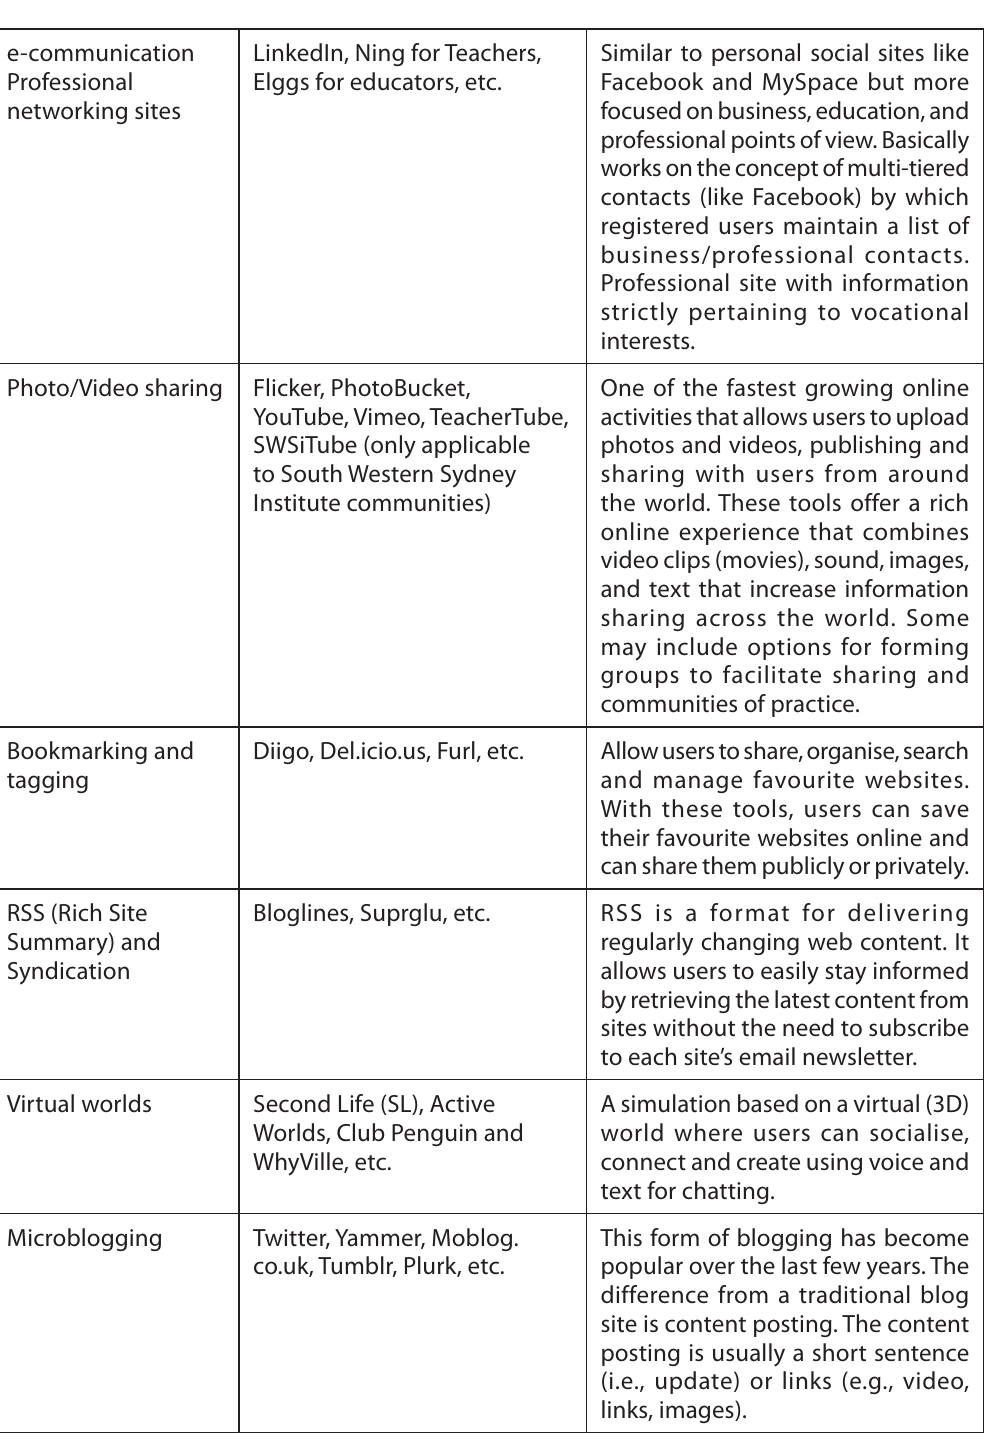
Table 1 Social networking tools (SNT) by functionality Source: Adapted from the Social Networking Toolbox site http://socialnetworking.swsi.wiki